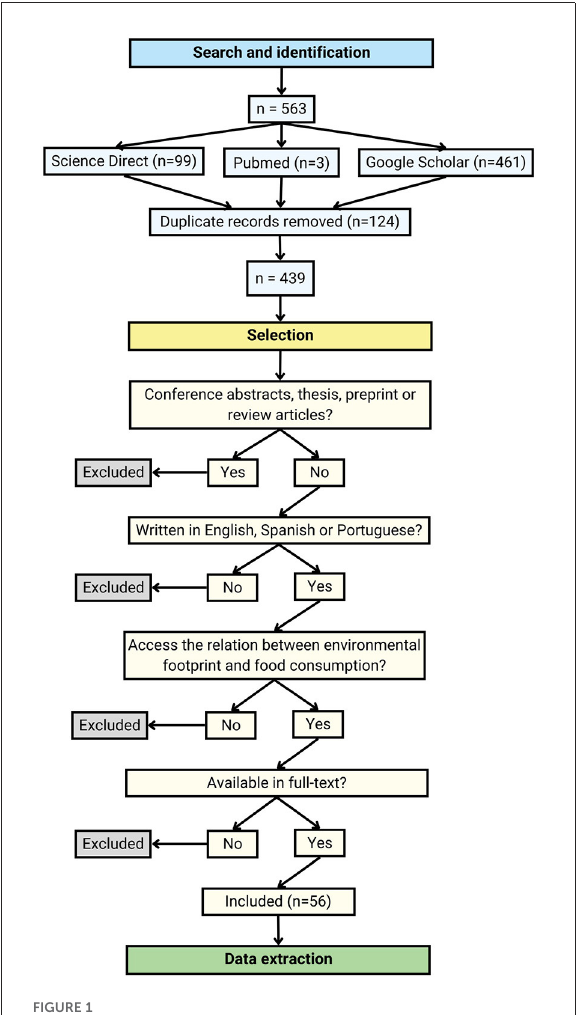
FIGURE1 Flowchart of study selection